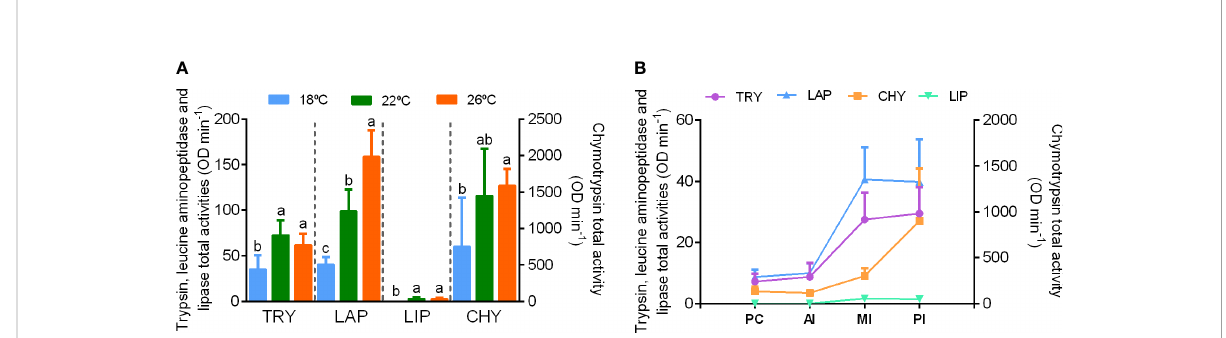
FIGURE 2 (A) Total activity of digestive enzymes in the intestinal tract of Seriola dumerili juveniles reared at 18 (blue), 22 (green) and 26°C (orange). (B) Total activity of digestive enzymes present in the gut sections of Seriola dumerili reared at 22°C. PC – pyloric caeca, AI – anterior intestine, MI – middle intestine, PI – posterior intestine. Chymotrypsin activity is represented in the right Y axis. TRY, trypsin; CHY, chymotrypsin; LAP, leucine aminopeptidase; LIP, lipase. Data is presented as means ± SD (n = 8). Different letters indicate signi fi cant differences for each enzyme among rearing temperatures (P<